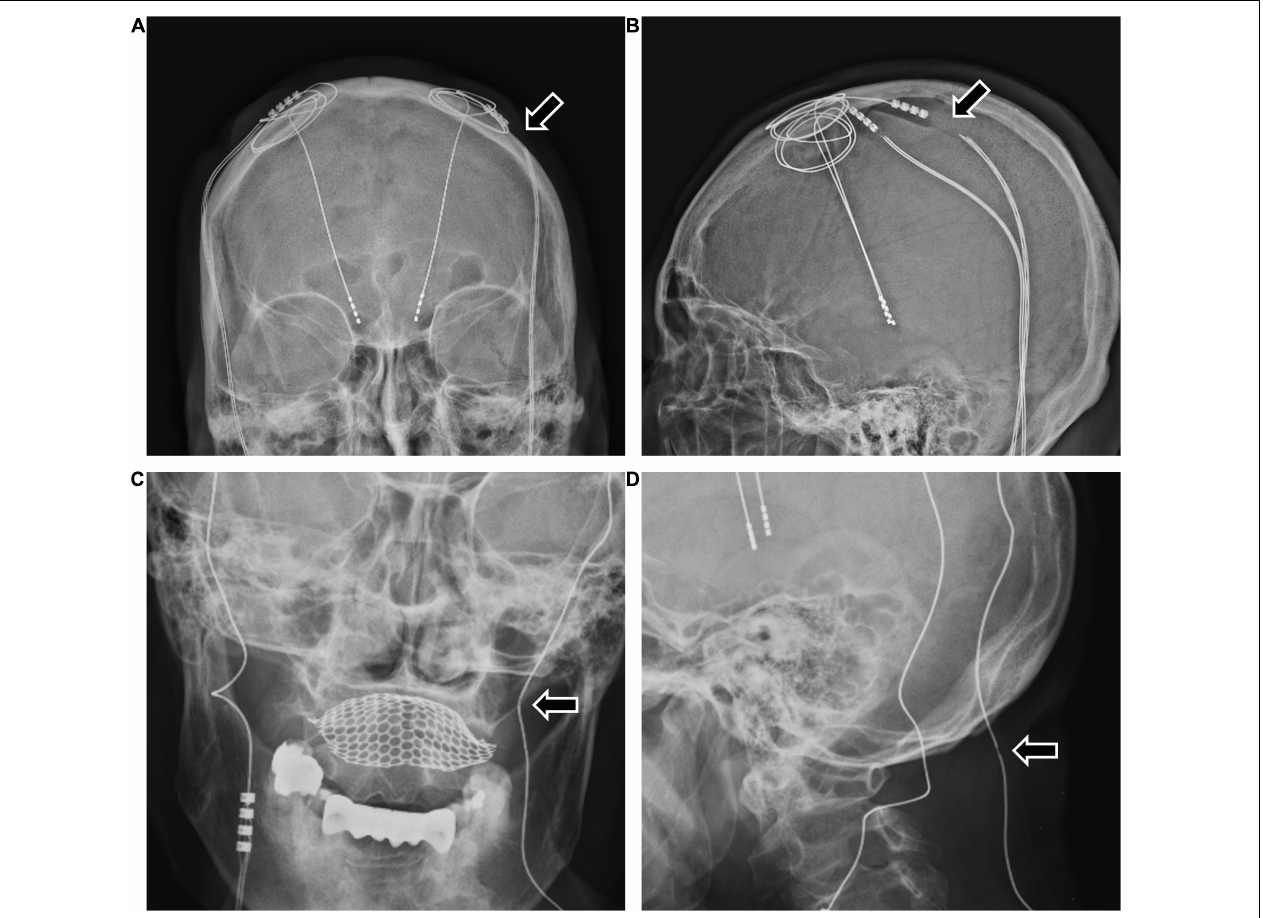
FIGURE 2 | The two patients with bilateral DBS with high impedance due to extension wire fracture or disconnection. (A,B) A 63-year-old woman with Parkinson’s disease experienced sudden worsening of symptoms 3 years after bilateral DBS. The examination revealed high impedance of the patient’s left DBS system due to extension fracture ( A,B arrows). After the revision operation to replace the extension wire, the patient’s DBS system was restored to normal function. (C,D) A 48-year-old woman with Parkinson’s disease experienced worsening symptoms 4 years after bilateral DBS. The examination revealed high impedance of the patient’s left DBS system and an extension wire abnormality ( C,D arrows). After the revision operation to replace the electrode and the extension wire, the patient’s DBS system was restored to normal function. DBS, deep brain stimulation.